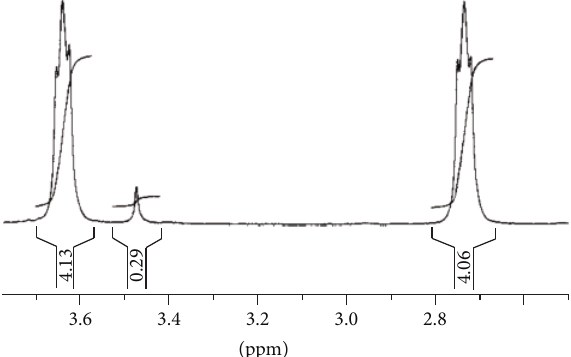
Figure 3: 1 H NMR signals for methylene protons of morpholine